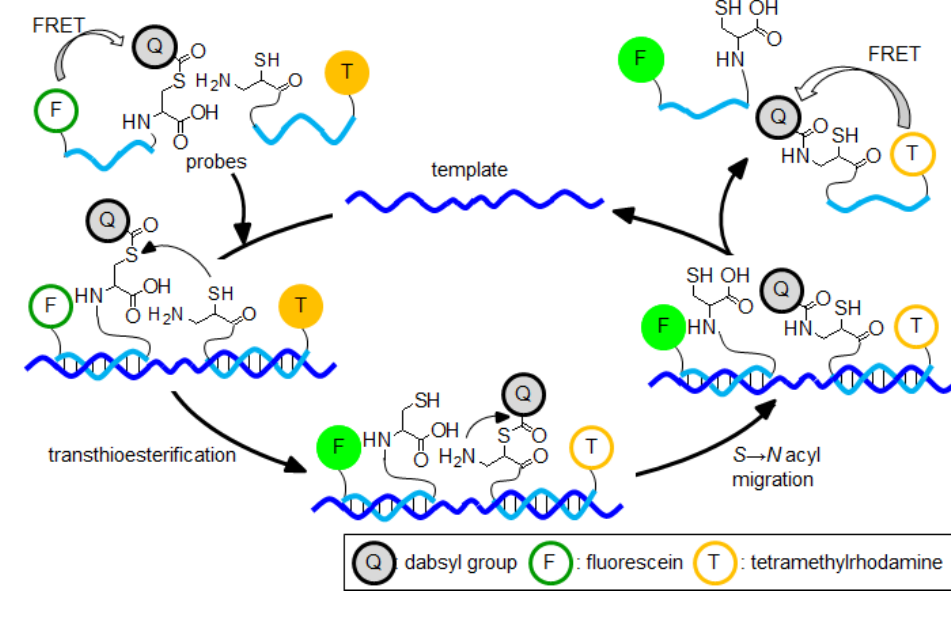
Figure 7. Catalytic cycle of the templated transfer of the reporter